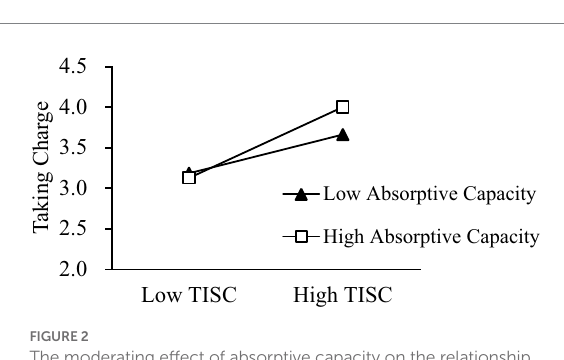
FIGURE 2 The moderating effect of absorptive capacity on the relationship between TISC and taking